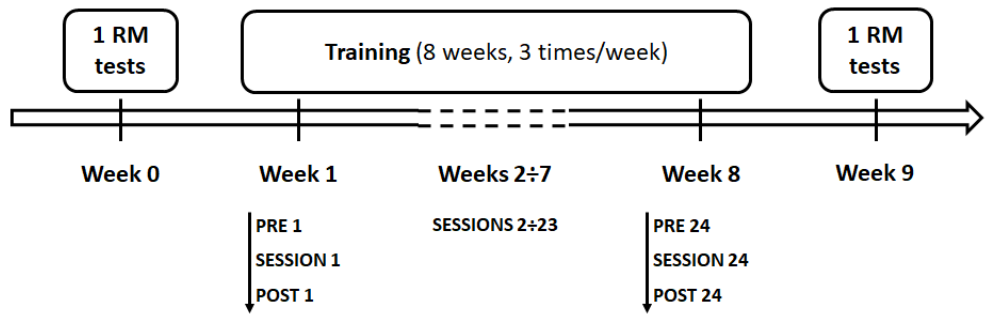
Figure 1. Experimental design. Before (Week 0, baseline measures) and after (Week 9, ending measures) the intervention period, participants underwent to the maximum repetition test (1RM test).